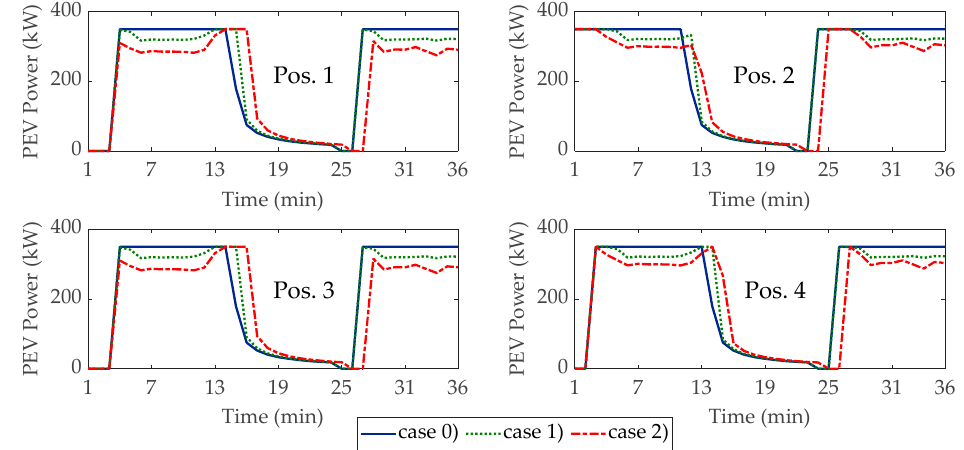
Figure 10. Power profile of the PEVs plugged-in the UFC station at bus #12 (UFCS 3 ) in the three case